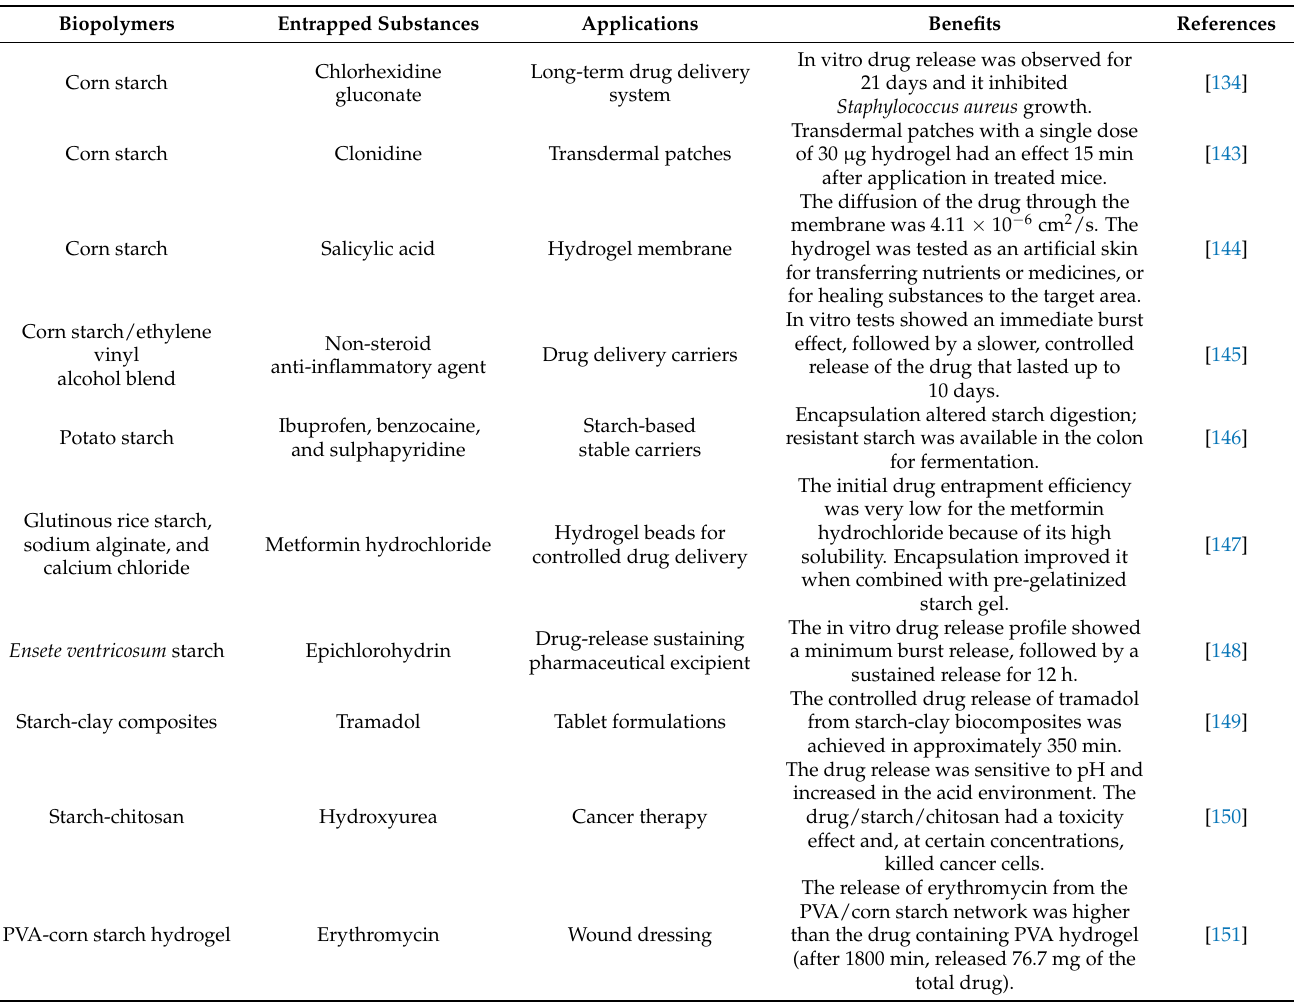
Table 4. Applications of starch for drug